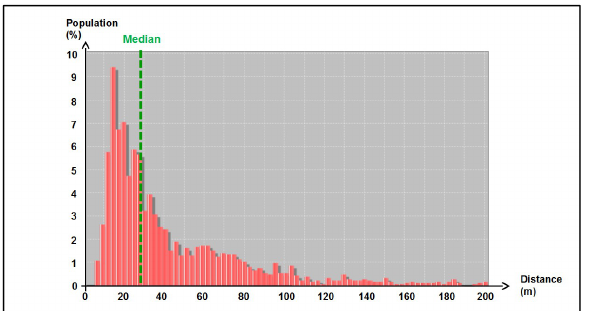
Figure 6. Inter-vertices distances of the road captured at the scale